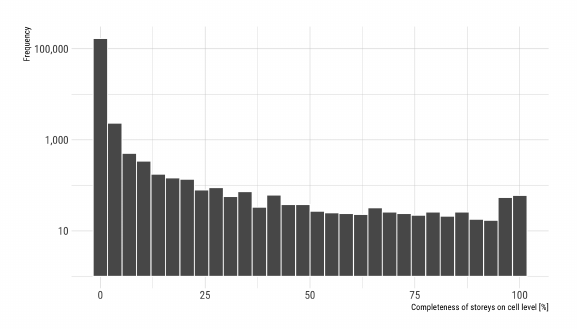
Figure 8. Completeness of height attributes on the tile-level (log- arithmic scale). Most tiles have none or almost none